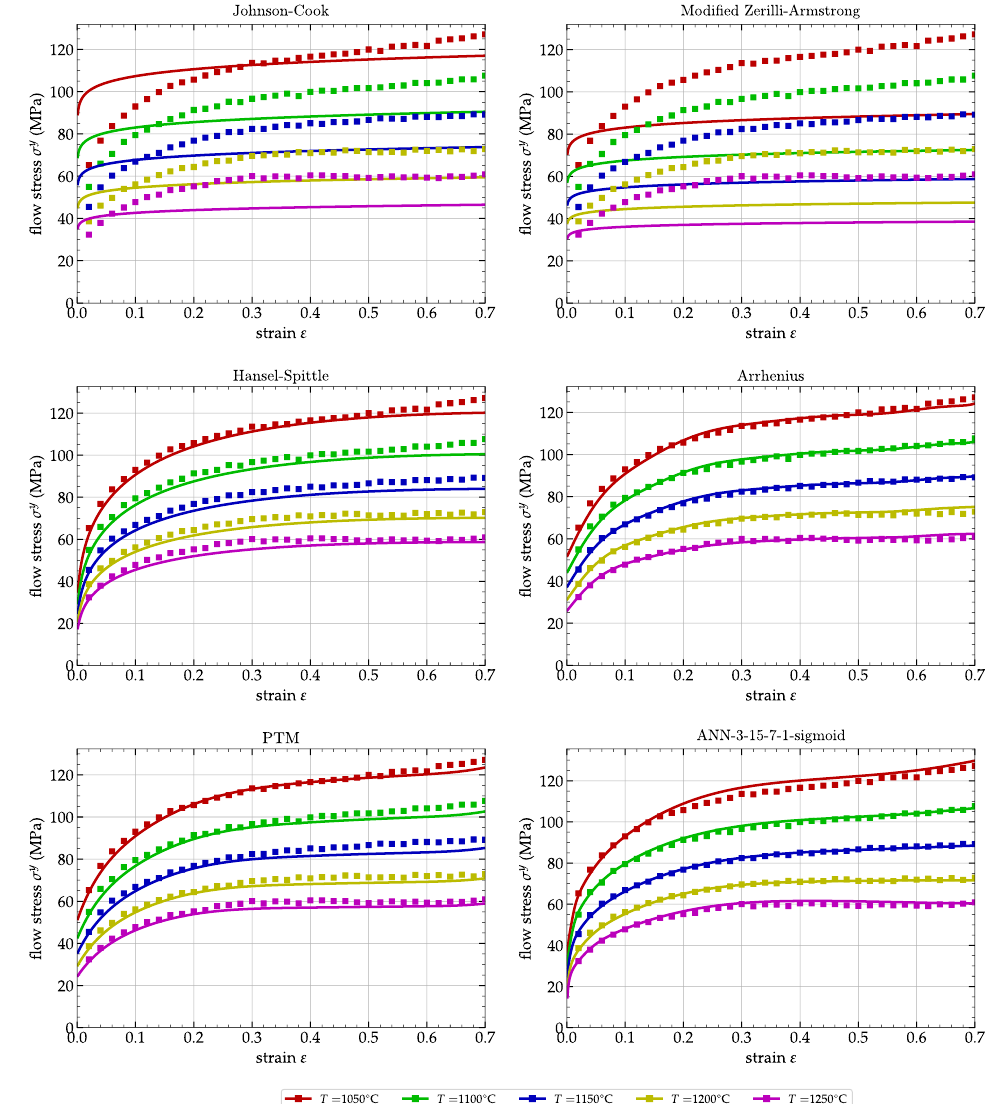
Figure 14. Comparison between the experimental (dots) and predicted (lines) flow stresses σ y for . ε = 1 s − 1